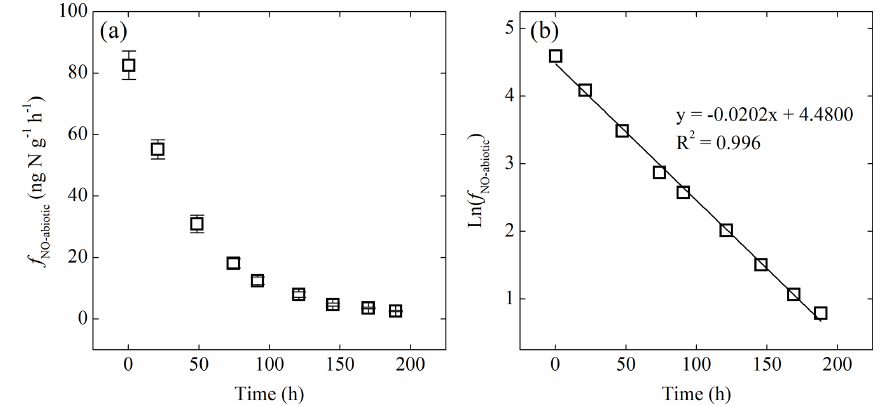
Figure 5. (a) Net NO production rate ( f NO-abiotic ) of the NO − of f NO-abiotic vs. time showing first-order decay of f NO-abiotic